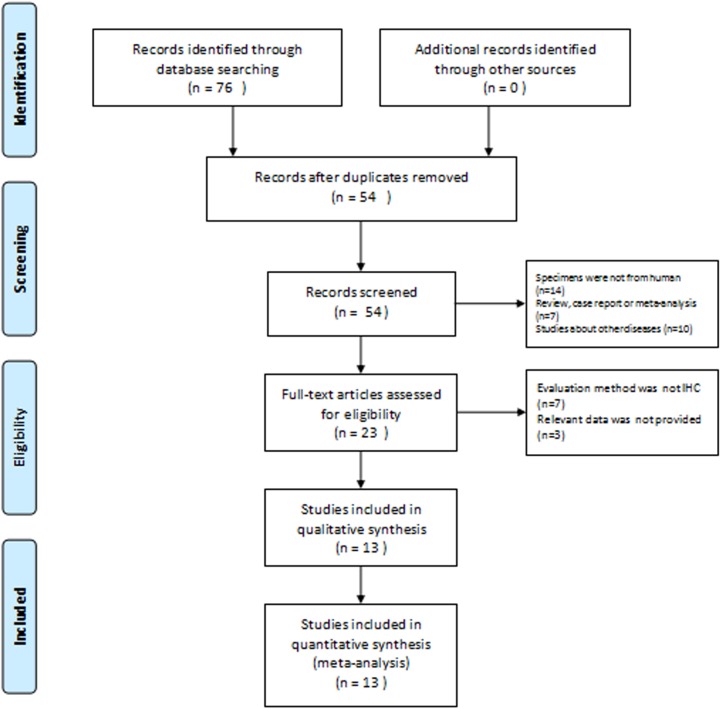
Flow diagram of study selection procedure.